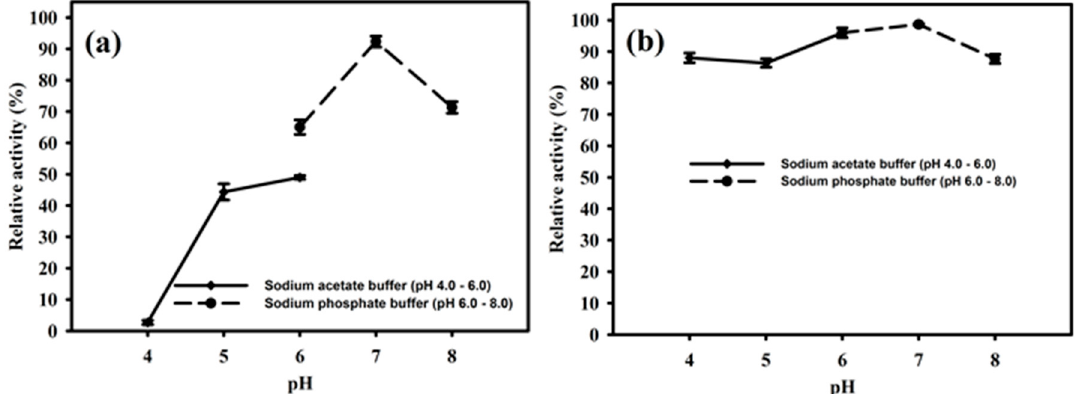
Figure 5. Effect of pH on the activity and stability of PhyRC001. ( a ) The optimal pH for PhyRC001 was determined by measuring the enzyme activity on 1% ( w / v ) Na-IHP in 50 mM buffers at 35 °C with various pH values. The buffers used to establish the optimum pH and to assess pH stability were as follows: sodium acetate buffer (pH 4–6, ♦ ), and sodium phosphate buffer (pH 6–8, ● ); and ( b ) to determine the pH stability of PhyRC001, the enzyme was incubated for 16 h at 4 °C in buffers of different pH values. The residual enzyme activity was measured under standard assay procedures. All measurements were carried out in triplicate.